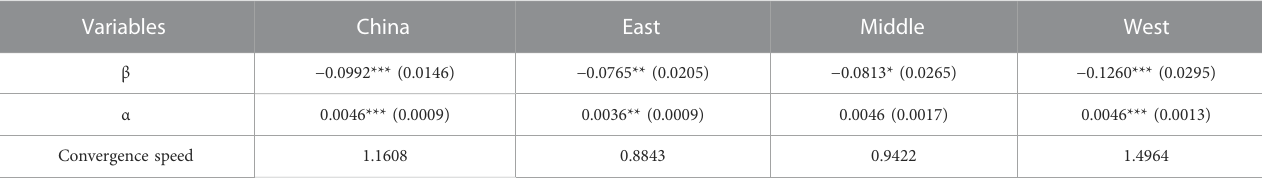
TABLE 2 Absolute β test results of GTFP in China and eastern, Central and Western urban agglomerations.